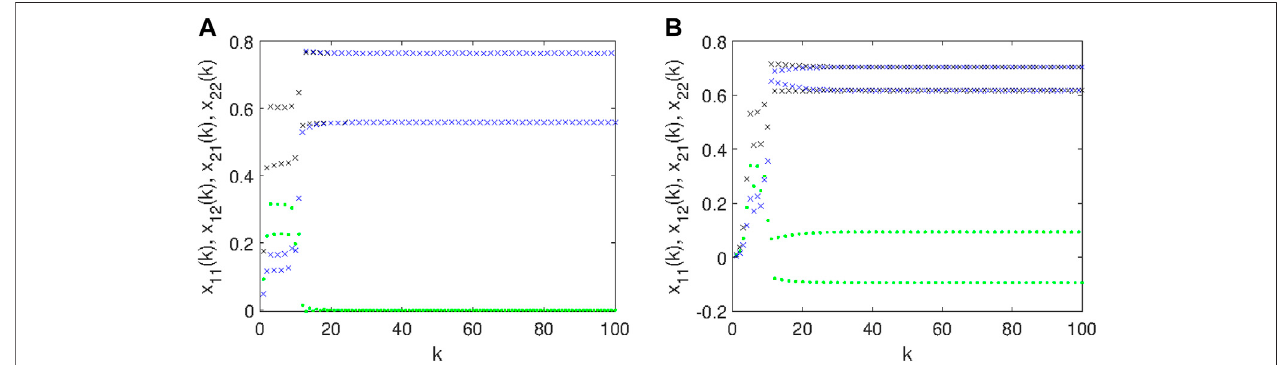
FIGURE5| Differentperiodicbehaviorofthemultidimensionallogisticmapin Eq.16 with N =2and a =3.1: (A) In-phaseperiodicityofthediagonalmaps x 11 ( k )and x 22 ( k ) leading to convergent off-diagonal maps x 12 ( k ) and x 21 ( k ); (B) anti-phase periodicity of the diagonal maps x 11 ( k ) and x 22 ( k ) leading to period-2 behavior also in the off-diagonal maps x 12 ( k ) and x 21 ( k ).